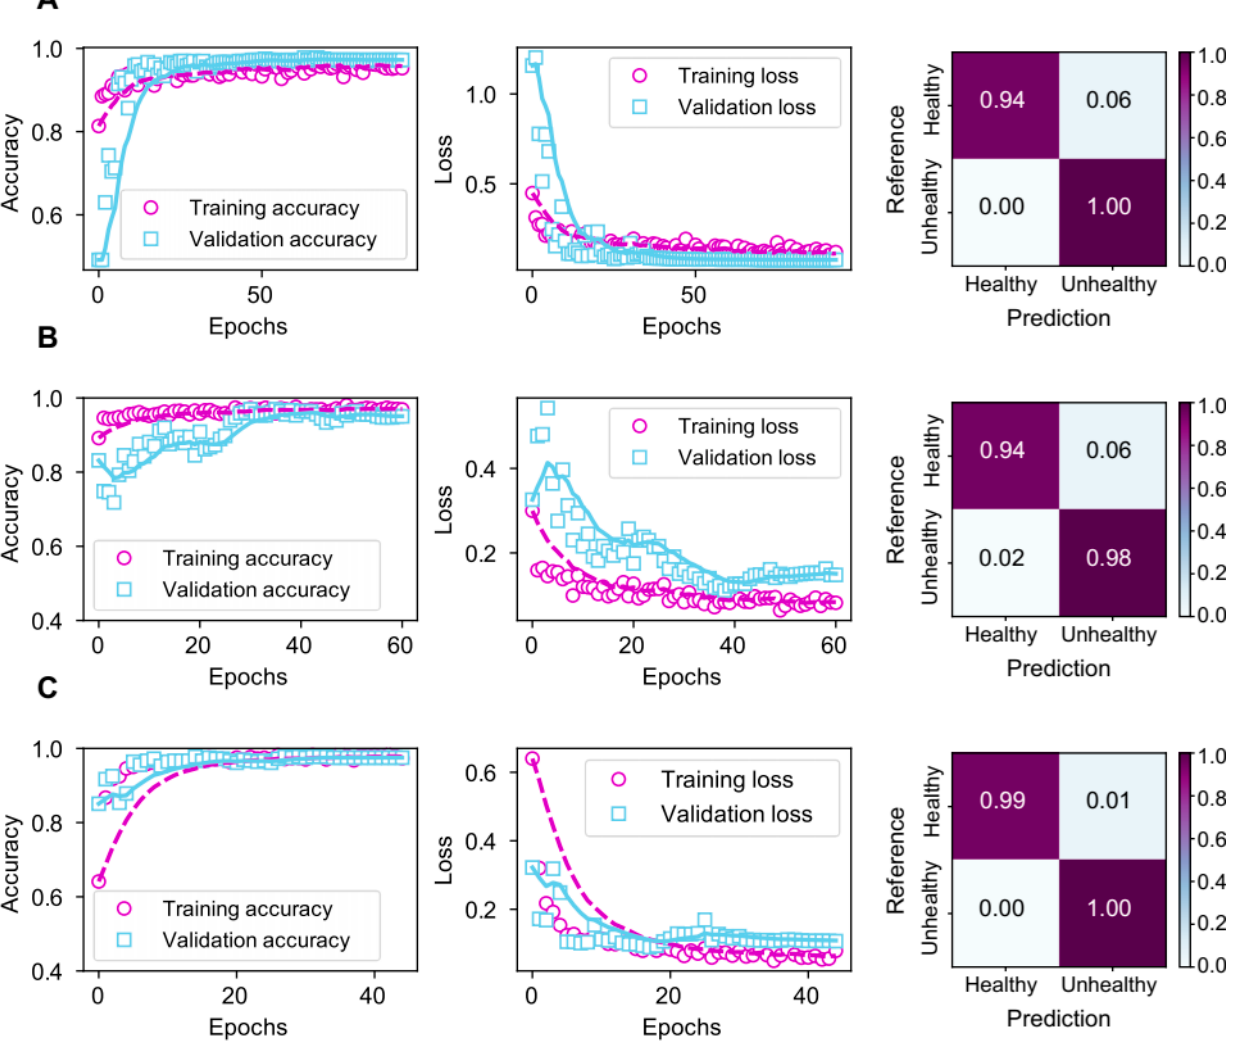
Figure 5. Performance of different convolutional neural network architectures (convnet) applied in the prediction of Fusarium head blight disease in wheat seeds. ( A ) A custom convnet after hyperparameter optimization. ( B ) MobileNet with 50% fine-tuning. ( C ) InceptionV3 with 100% fine-tuning. The scatter plots show the accuracy (left panel) and loss (middle panel) during the interactions over the epochs. The right panel shows the test confusion matrix for each convnet architecture.